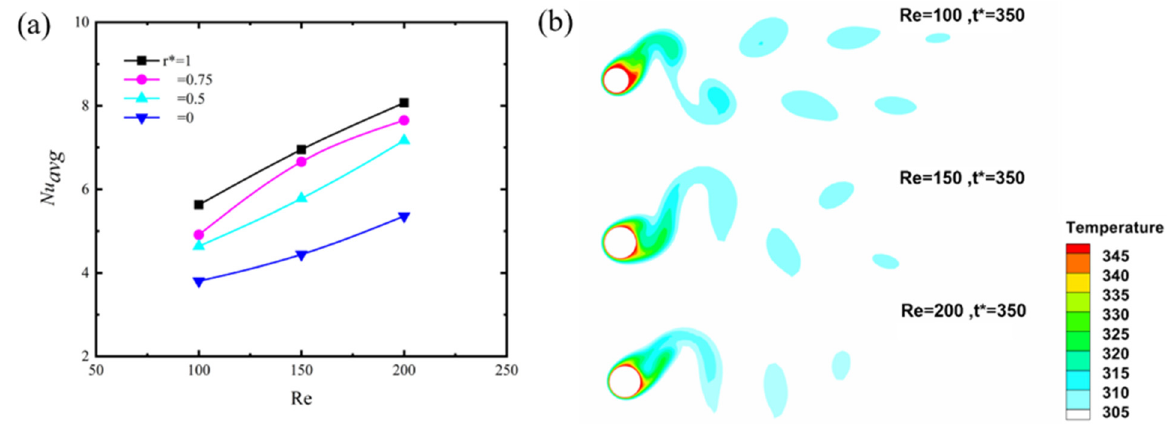
Figure 10. Effect of r* on heat transfer with vortex-induced vibration at different Re. ( a ) Average Nusselt number Nu avg vs. Re. ( b ) Temperature contour of the heated cylinder.